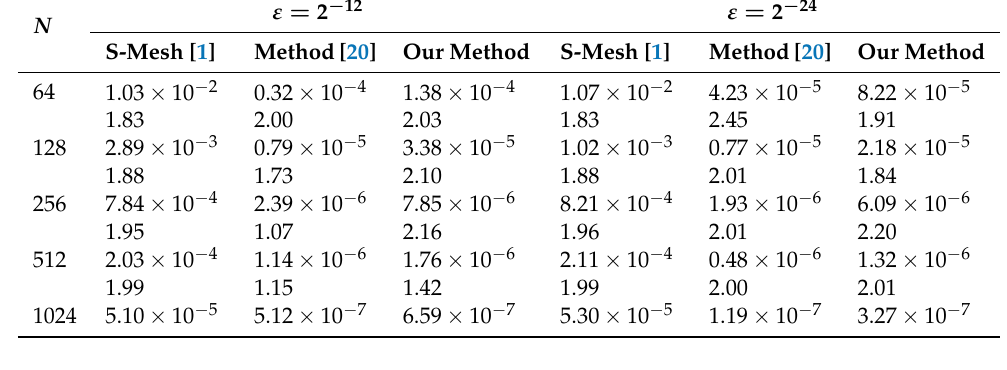
Table 4. Comparison of numerical results with the other methods for Example 2.